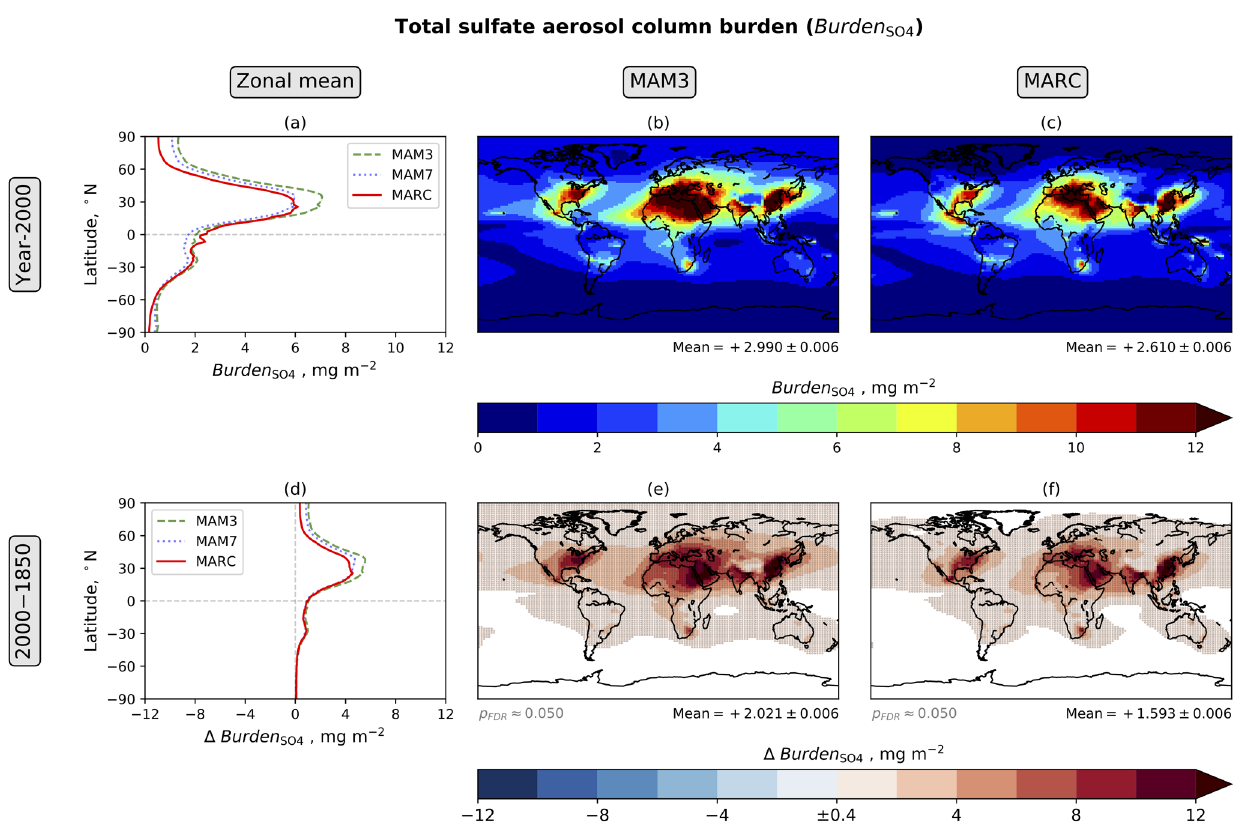
Figure 2. Annual mean total sulfate aerosol burden (Burden SO ). For the zonal means (a, d) , the standard errors, calculated using the annual 4 zonal mean for each simulation year, are indicated by shading; however, this shading is not visible in Fig. 2, because the standard errors are smaller than the width of the plotted lines. For the maps (b, c, e, f) , the area-weighted global mean and associated standard error, calculated using the annual global mean for each simulation year, are shown below each map. For the maps showing aerosol-induced 2000–1850 differences (e, f) , white indicates differences with a magnitude less than the threshold value in the centre of the colour bar ( ± 0 . 4mgm − 2 ). For locations where the magnitude is greater than this threshold value, stippling indicates differences that are statistically significant at a significance level of 0.05 after controlling the false discovery rate (Benjamini and Hochberg, 1995; Wilks, 2016); the two-tailed p values are generated by Welch’s unequal variances t test, using annual mean data from each simulation year as the input; the approximate p value threshold, p FDR , which takes the false discovery rate into account, is written below each map. The analysis period is 30 years. For MARC, the aerosol burdens (Figs. 2–6) have been calculated using monthly mass-mixing